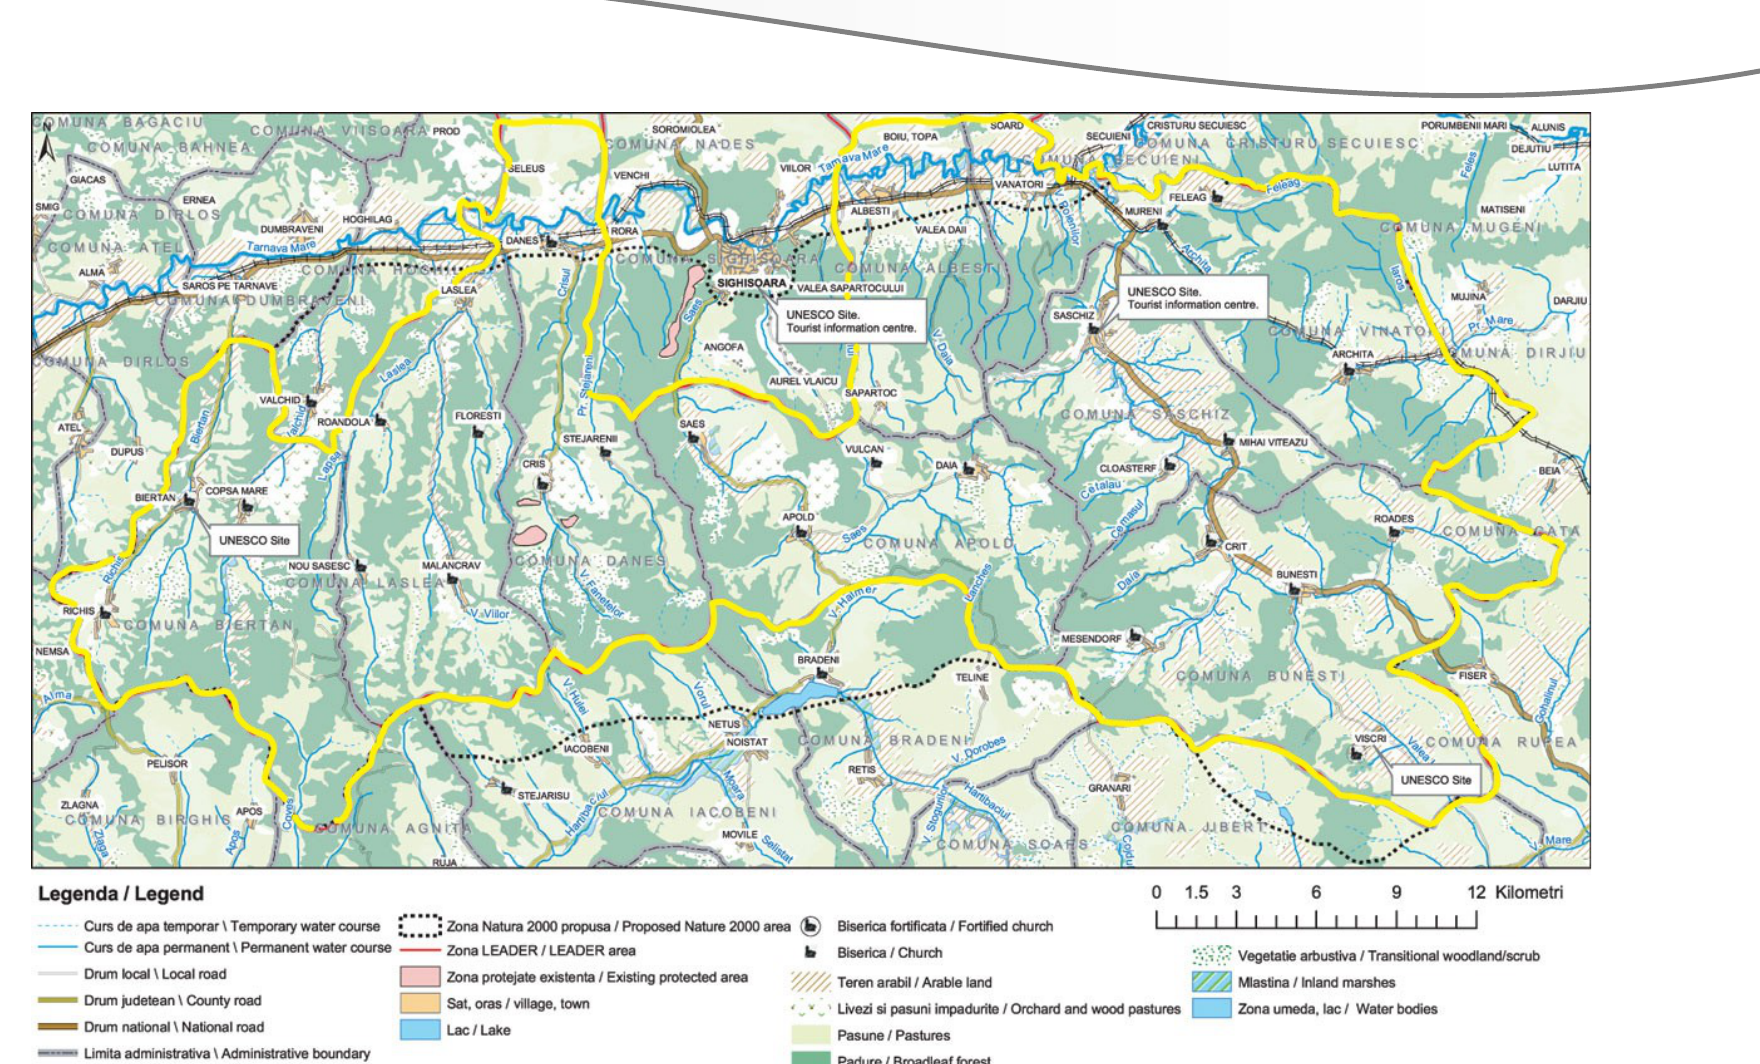
Figure 2: Research area where cases were